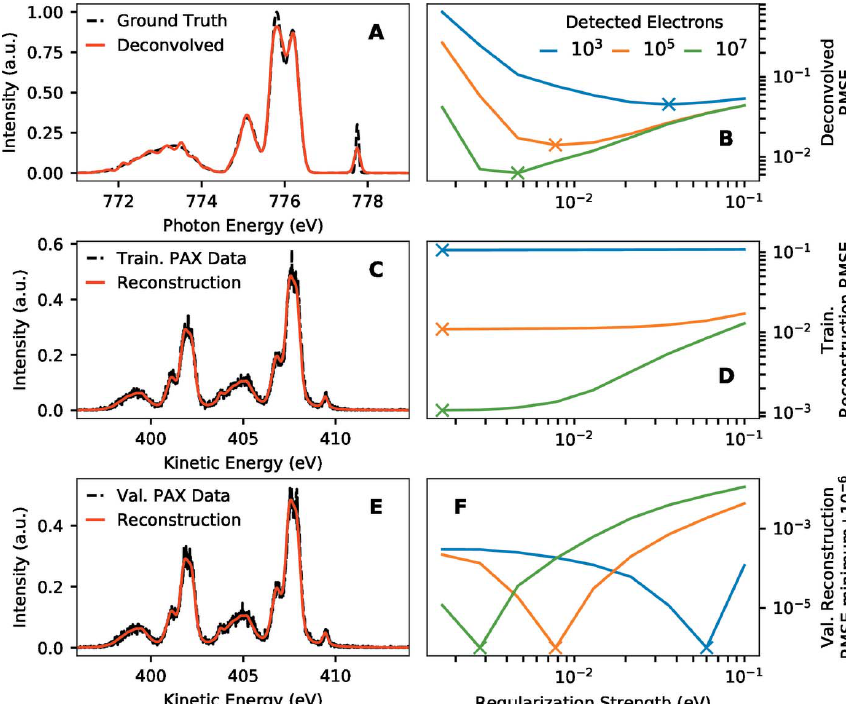
Figure 4 Illustration of how the quality of reconstruction of PAX spectra from deconvolved spectra can be used to estimate the optimal regularization strength. The panels on the left show example simulated data with 10 5 simulated detected electrons and a regularization strength of 7.7 meV. (A) Example ground truth spectrum and an estimate of it obtained by deconvolving simulated data. (B) Corresponding root mean squared error (RMSE) of the deconvolved spectrum as a function of the regularization strength and the number of simulated detected electrons. (C) PAX spectrum obtained by averaging a training set of data (data that were used in deconvolution) and its reconstruction from the deconvolved result. The incident photon energy of 778 eV (Co L 3 ) combined with the Ag 3 d binding energies near 370 eV (Panaccione et al. , 2005) give electron kinetic energies near 405 eV in the PAX spectrum. (D) Corresponding RMSE of the reconstruction of the training data for the same parameters as (A). (E) PAX spectrum obtained by averaging a validation set of data (data that were not used in deconvolution) and its reconstruction from the deconvolved result. (F) Corresponding RMSE of the validation data for the same parameters as (A). The data of panel (F) are shown with the minimum of each curve subtracted and a small offset added in order to highlight the locations of minima. Since the validation reconstruction error is minimized at similar regularization strengths as the deconvolved error, we can estimate the optimal regularization strength from the validation reconstruction